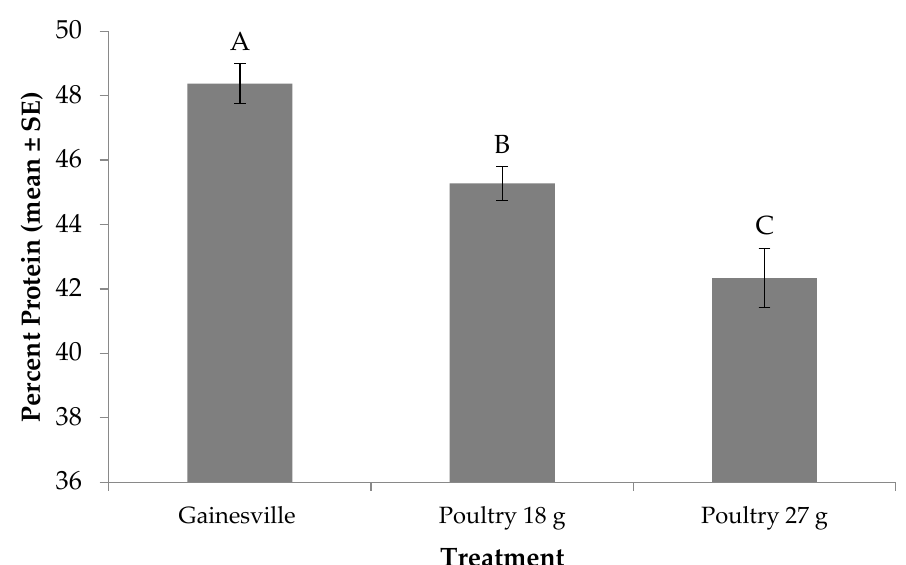
Figure 3. Percent protein (mean ± SE, 1 n = 6) for black soldier fly larvae fed Gainesville diet [32] or poultry manure at two feed rates every other day at 29 ◦ C, 60% RH, and 16L:8D. Di ff erent letters indicate significant di ff erences between treatments ( α = 0.05), ANOVA followed by Tukey’s HSD (honest significant di ff erence). 1 n = number of replicates per treatment.